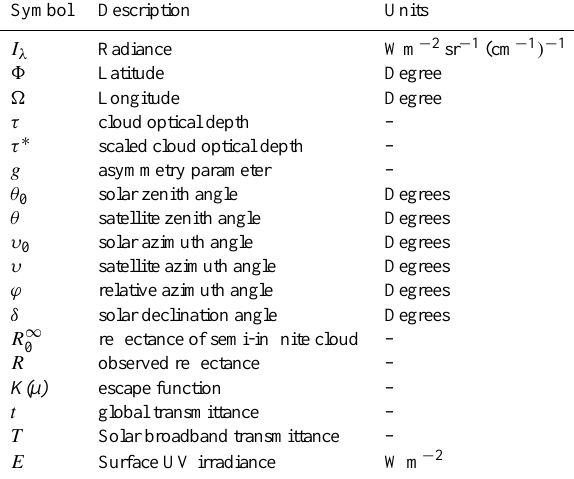
Table B1. List of